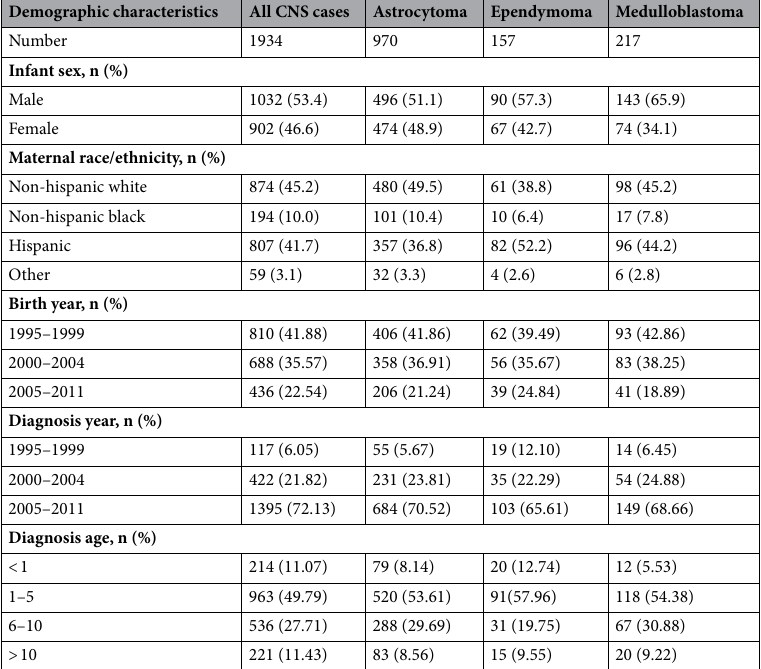
Table 1. Demographic characteristics of children diagnosed with central nervous system